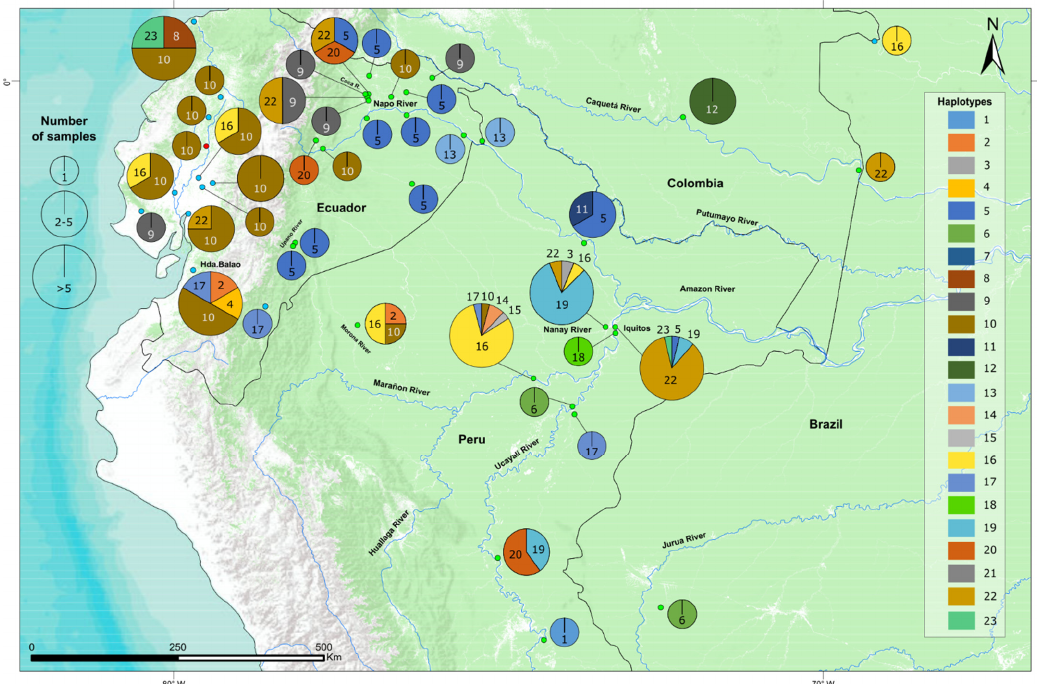
Figure 3. Distribution and frequencies of chloroplast haplotypes among Theobroma cacao L. populations in western Amazonia. The green dots represent samples from natural populations, the blue dots plantations, and the red dots accessions in breeding stations. The size of the circles is proportional to the number of samples per location. Table 2. Chloroplast haplotype diversity within cacao populations in western and eastern Amazo- nia. Amazonia N N Loc N h H S H T